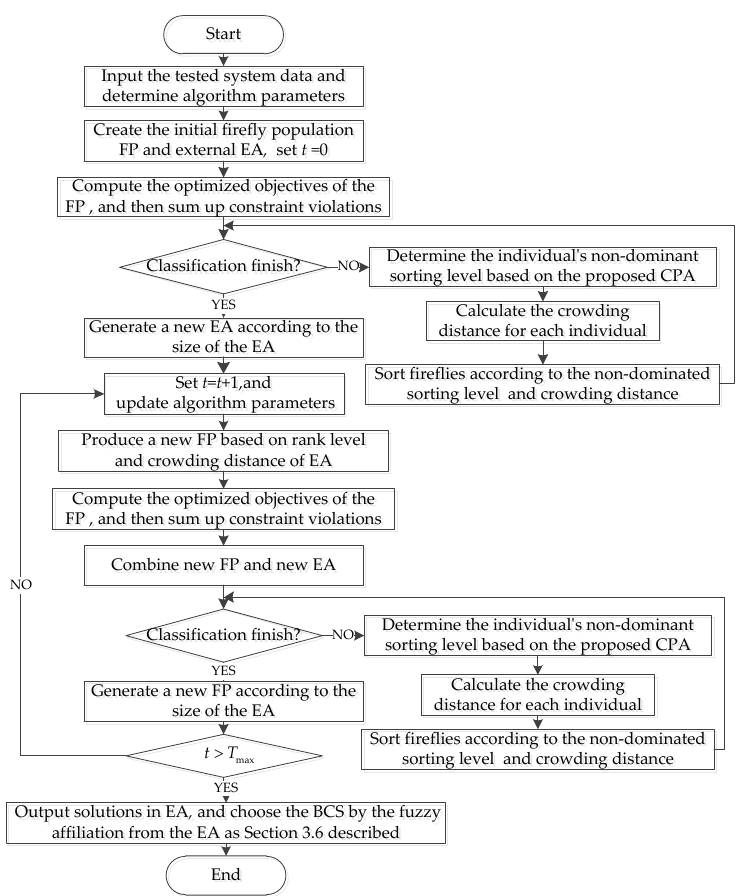
Figure A1. Flowchart of the MOFA-CPA algorithm for the MOOPF problem.